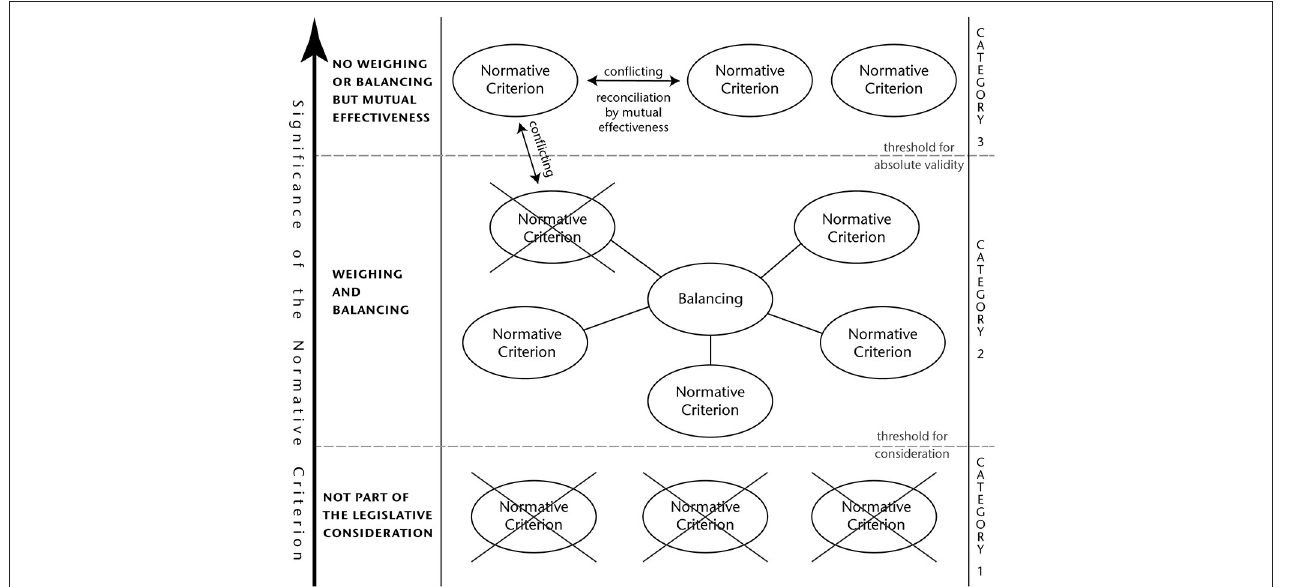
FIGURE 1 | Nexus of the normative criteria and the regulatory implications.